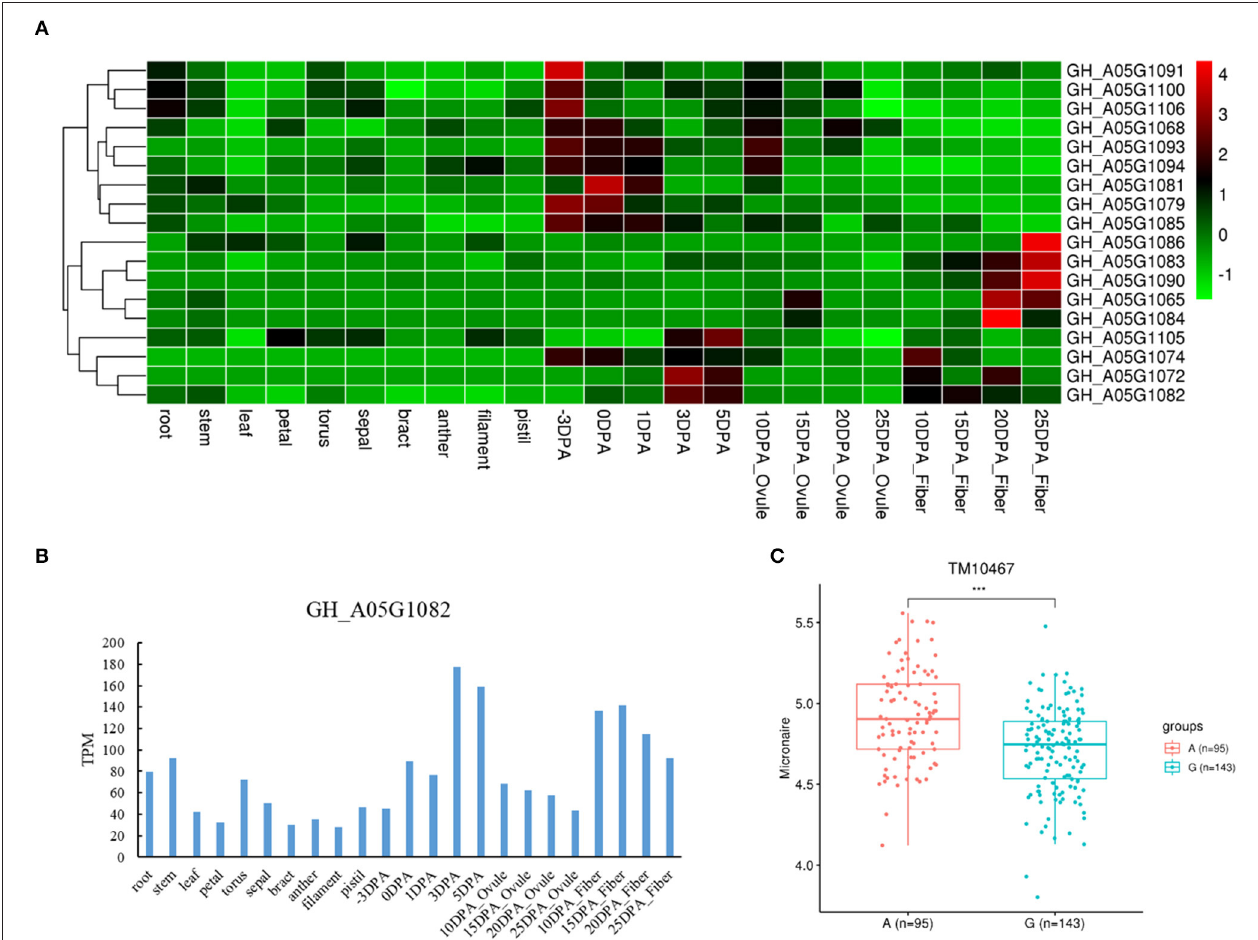
FIGURE 6 | Quantitative trait loci (QTLs) and candidate genes located on qtl9 on chromosome A05. (A) Expression heatmap of candidate genes in the qtl9. (B) The expression patterns of the GH_A05G1082 in different tissues. (C) Boxplots for the phenotypic values of quantitative trait nucleotide (QTN) in exon of the GH_A05G1082 . *** P <